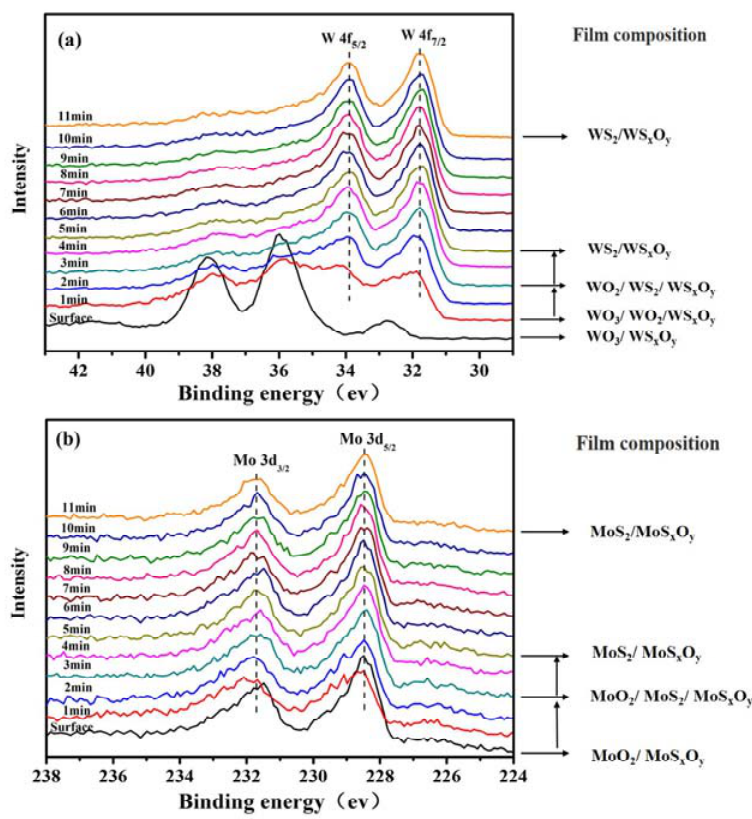
Figure 7. XPS depth profiles of MoS 2 –WS 2 composite film: ( a ) W 4f, ( b ) Mo 3d after atomic oxygen irradiation.